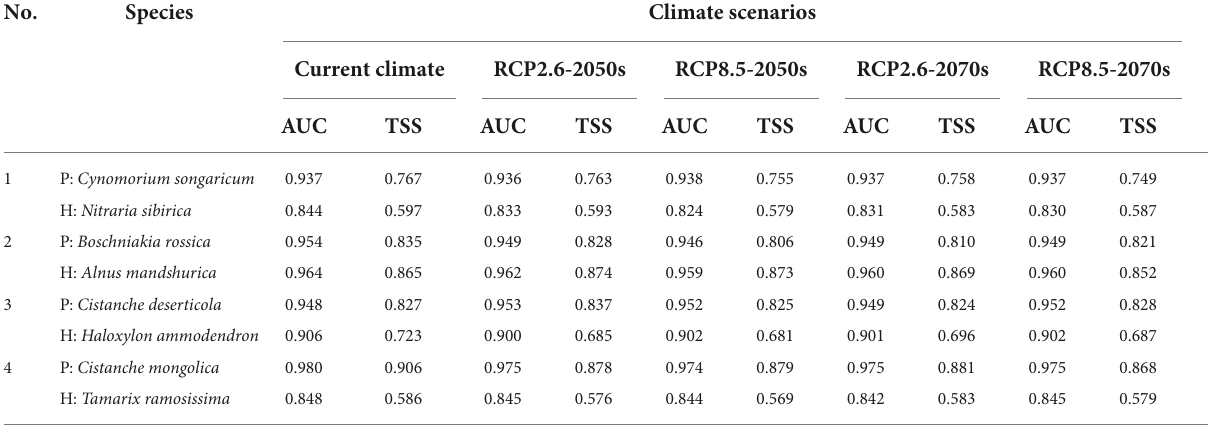
TABLE 1 Area under curve and TSS values of four holoparasitic plants and their primary hosts under different climate scenarios in China. No.